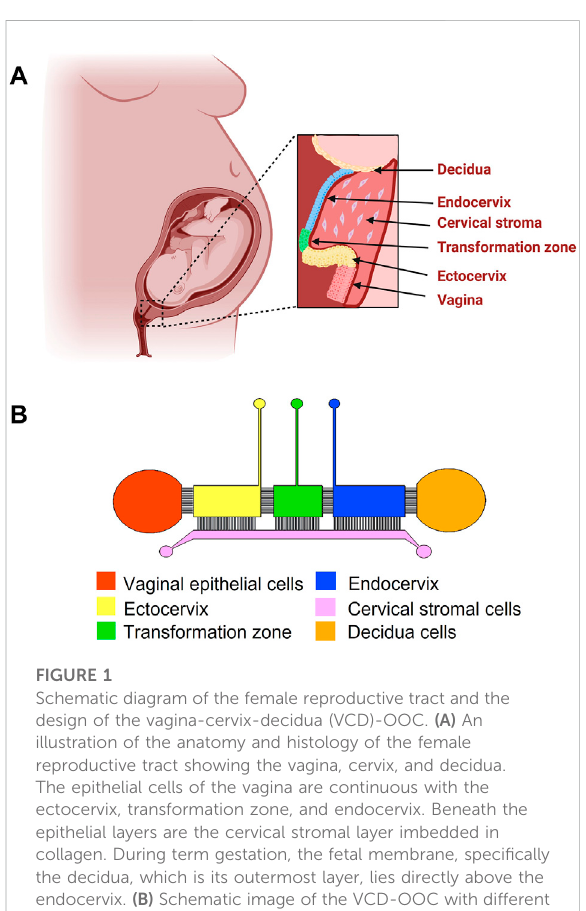
FIGURE 1 Schematic diagram of the female reproductive tract and the design of the vagina-cervix-decidua (VCD)-OOC. (A) An illustration of the anatomy and histology of the female reproductive tract showing the vagina, cervix, and decidua. The epithelial cells of the vagina are continuous with the ectocervix, transformation zone, and endocervix. Beneath the epithelial layers are the cervical stromal layer imbedded in collagen. During term gestation, the fetal membrane, speci fi cally the decidua, which is its outermost layer, lies directly above the endocervix. (B) Schematic image of the VCD-OOC with different cell culture chambers represented by different colors and connected with each other by an array of